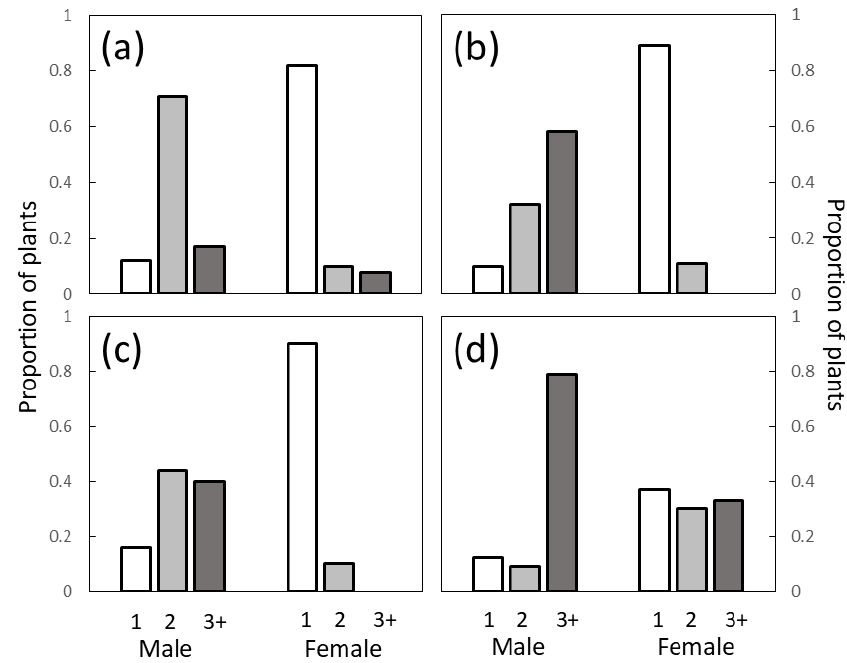
Figure 2. The influence of sex on the proportion of plants with 1, 2 or 3 + branches. ( a ) Cycas micronesica ; ( b ) Cycas wadei ; ( c ) Cycas edentata ; ( d ) Zamia encephalartoides . Table 1. The influence of sex on stem branching of four cycad species. Significance determined by the Mann – Whitney U test. Means ± standard error.